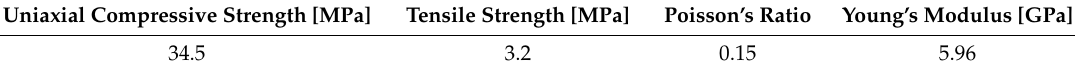
Table 1. Material properties of the gypsum